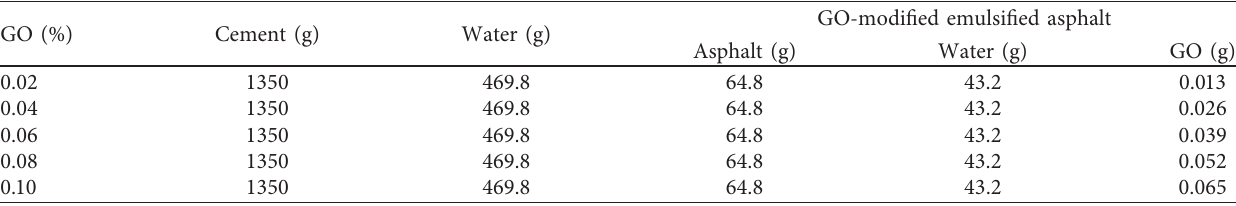
Table 5: The mix proportion of